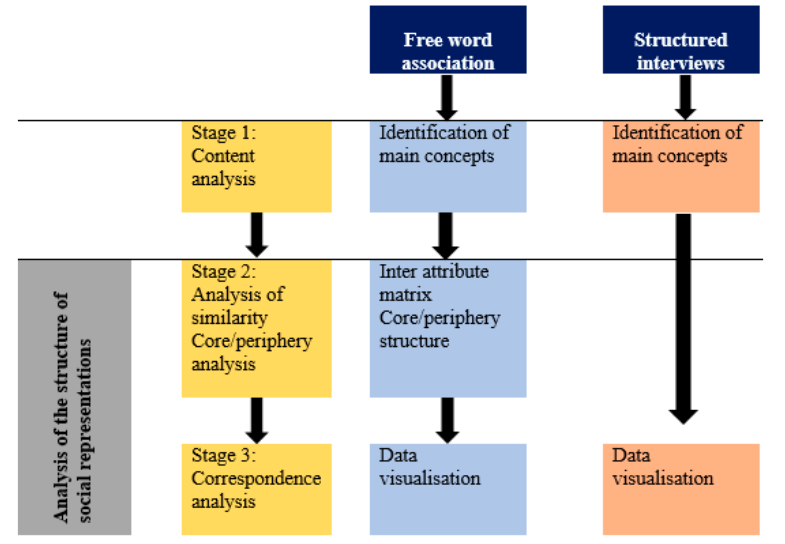
Figure 1. Social representations